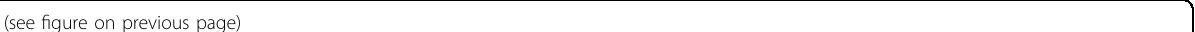
(see fi gure on previous page) Fig. 2 dDpMe GABA neurons are essential for REM sleep suppression and REM-to-NREM transitions. a Schematic of optogenetic experiments with EEG/EMG recordings in a GAD2-IRES-Cre mouse with an AAV carrying Cre-dependent ChR2-mCherry injected into the dDpMe. Drawings of superimposed ChR2-mCherry-expressing sites with micropipette tips ( n = 5, circles indicate tips and irregular shapes indicate expressing sites) and a typical fl uorescent image representing the dDpMe labeled by ChR2-mCherry, dorsomedial to the ChAT-labeled PPT. b All trials ( n = 172) and the probabilities of different brain states from fi ve mice before, during, and after blue-light delivery (30 Hz, 120 s). c An example recording shows the EEG power spectrograms, EEG/EMG traces, and hypnograms after bilateral laser onset above the dDpMe in terms of REM sleep. Right, the power density of dDpMe GABA ChR2 and dDpMe GABA mCherry groups during different phases of laser stimulation from REM sleep (pre-stimulation, stimulation, and post-stimulation). d The probabilities of different brain states in GAD2-IRES-Cre mice after laser onset falling on REM sleep. The red lines indicate a statistical difference between the ChR2-mCherry and mCherry group ( F (1,637)(REM) = 301.10, P < 0.001; F (1,637)(NREM) = 92.97, P < 0.001). e The pie charts and histograms show changes in brain states during laser stimulation initiated from different brain states (REM → NREM, P = 2.3 × 10 − 12 ; Wake → NREM, P = 7.9 × 10 − 9 ; ChR2-mCherry group, n = 5; mCherry group, n = 4). f Schematic of optogenetic experiments with EEG/EMG recordings of a GAD2-IRES-Cre mouse with Cre-dependent eNpHR-eYFP AAV injected into the dDpMe. Drawings of superimposed eYFP-expressing sites with the position of micropipette tips ( n = 6) and typical fl uorescent images in the dDpMe are shown, dorsomedial to the ChAT-labelled PPT (red). g All trials ( n = 163) and the probabilities of different brain states from six mice before, during, and after constant 593-nm laser exposure. h Example recording of EEG power spectrograms, EEG/EMG traces, and hypnograms after bilateral laser stimulation above the dDpMe (593nm, 60 s) in terms of NREM sleep. The power density of dDpMe GABA eNpHR and dDpMe GABA eYFP groups during different phases of laser onset falling on NREM sleep (pre-stimulation, stimulation, and post-stimulation). i The probabilities of different brain states in GAD2-IRES-Cre mice after laser onset falling on NREM sleep. The red lines indicate a signi fi cant difference between the eNpHR-eYFP or eYFP group (in NREM: F (1,608)(REM) = 174.4, P < 0.001; F (1,608)(NREM) = 130.2, P < 0.001). j Pie charts and histograms showing major states during laser stimulation initiated from different brain states, which were assessed by two-tailed t -tests: eNpHR-eYFP group, P NREM → REM = 9.0 × 10 − 6 ; eNpHR-eYFP group, n = 6; eYFP group, n = 4. Data represent means ± SEM. * P < 0.05, ** P < 0.001. The red or yellow horizontal lines in power density analysis indicate a statistical difference between pre- stimulation, stimulation, or post-stimulation ( P < 0.05, red for pre-stimulation and stimulation; yellow for pre-stimulation and post-stimulation, two- way ANOVA with posthoc of the Sidak ’ s multiple comparisons test). DR dorsal